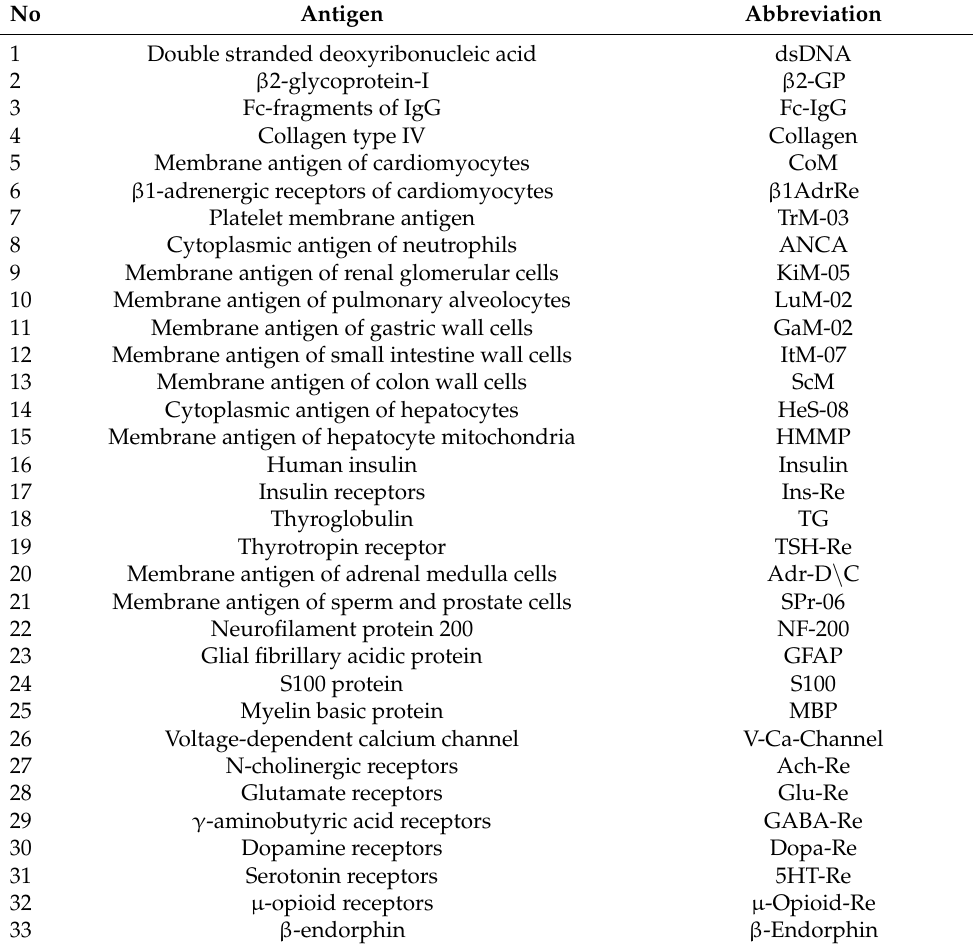
Table 1. List of antigens, included in the test systems ELI-Viscero-test-24 and ELI-N-test-12. No Antigen